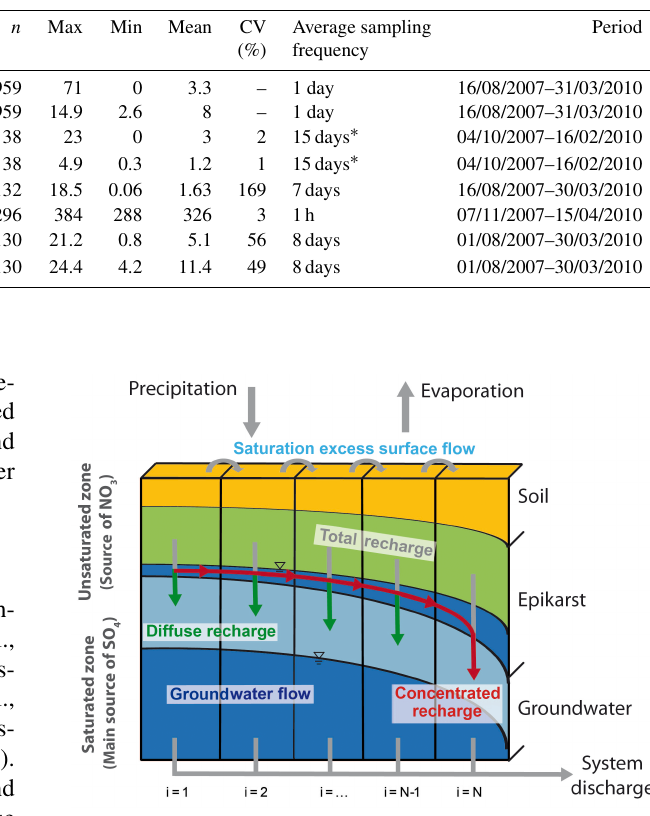
Figure 3. Schematic representation of the VarKarst model structure (modified from Hartmann et al.,